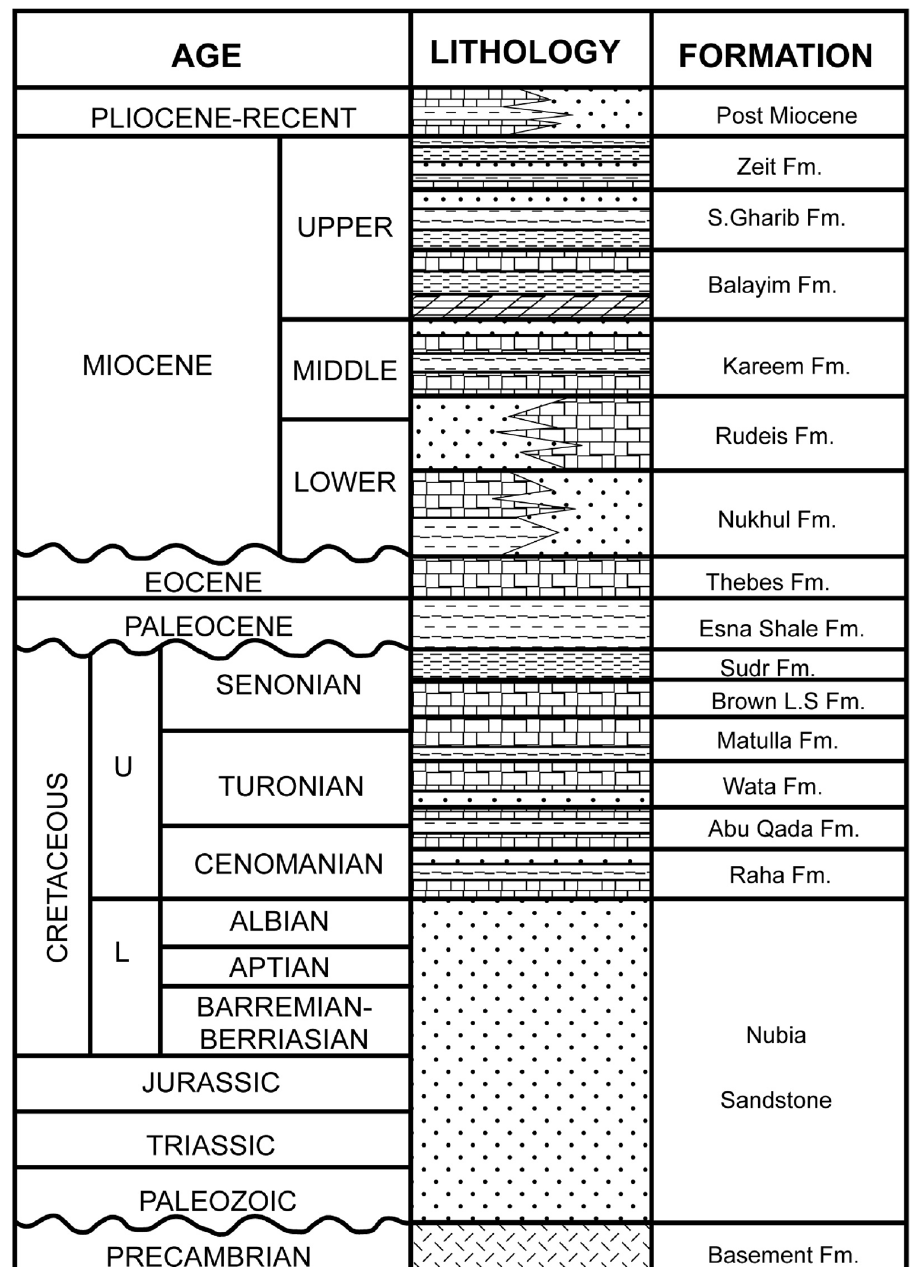
Fig. 3 Simplified